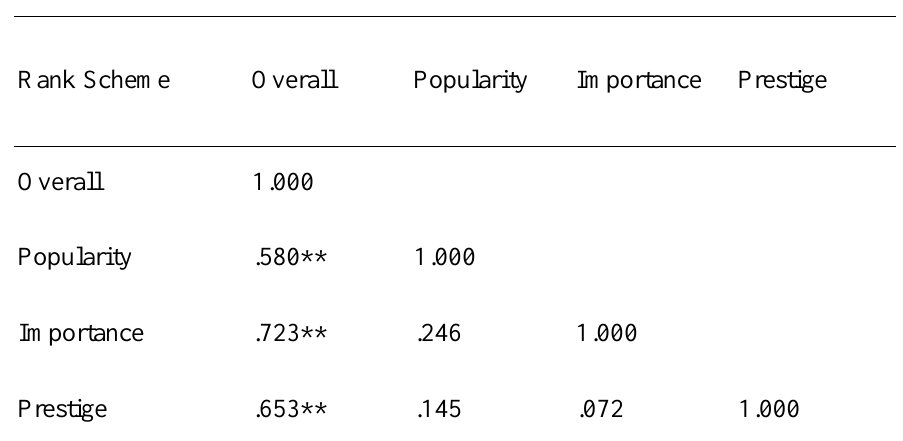
Correlation Matrix of Indexes between Overall Rank and the Three Ranking Schemas (N = 46)